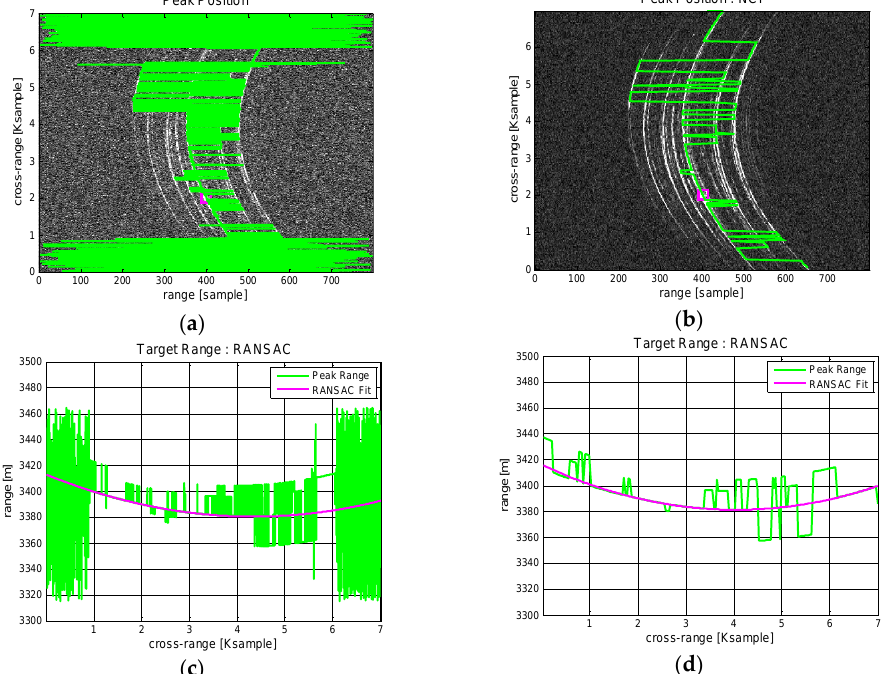
Figure 10. Boeing 747 ISAR data range tracking results: ( a ) Peak detection; ( b ) Peak detection with NCI; ( c ) Trajectory modelling by RANSAC; ( d ) Trajectory modelling by RANSAC with NCI. Doppler centroid estimation is carried out from the previously obtained range information. For this purpose, the ACCC algorithm is applied across the azimuth and the results are shown in Figure 11. Initially, aliasing effects are visible along the calculated Doppler history in Figure 11a. On the assumption of parabolic range trajectory, the ambiguity number can be directly estimated from the geometry model and Figure 11b shows the result. To discard the ambiguity, phase unwrapping is applied and the absolute Doppler history is restored in Figure 11c.